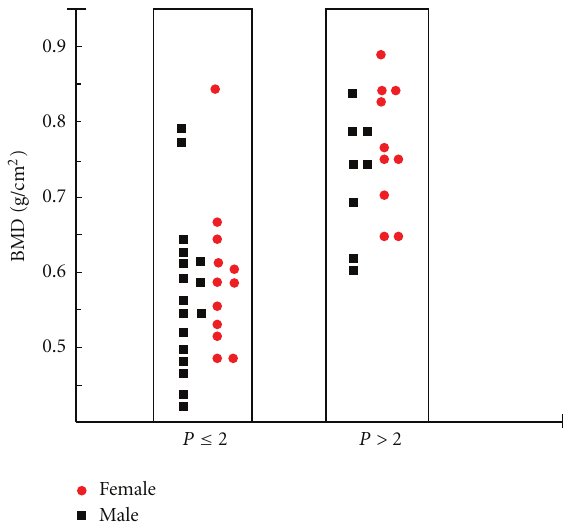
Figure 3: Puberty-bone mass density relationships in patients with thalassemia